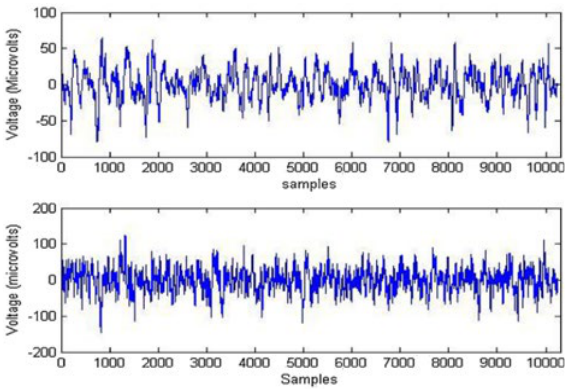
Figure 7. Example of Focal ( top ) and Non-Focal ( bottom ) EEG signals.